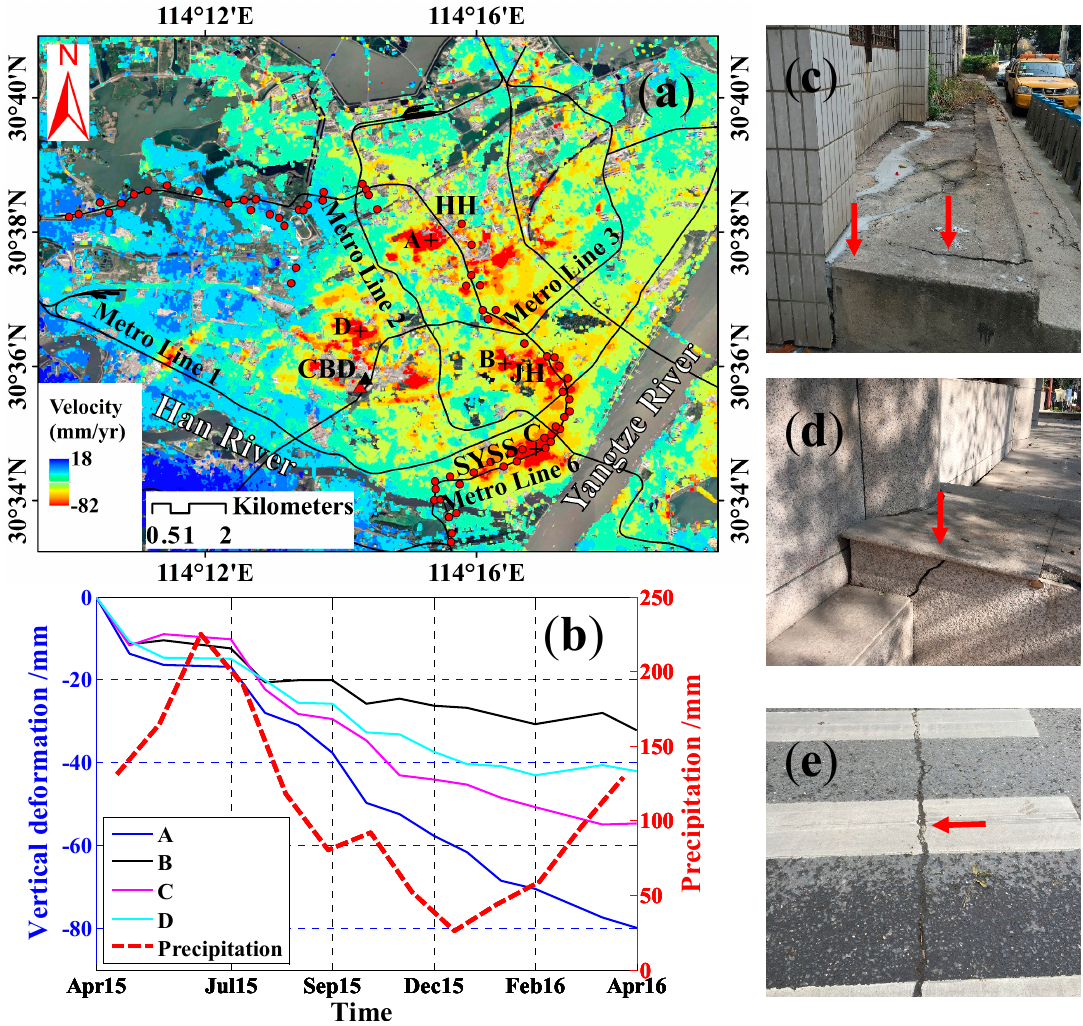
Figure 8. Surface vertical deformation rate map derived by SBAS InSAR superimposed on Google Earth image covering ( a ) Region S1. Black lines denote Wuhan Metro Lines, including metro lines in operation and under construction. Red circles represent leveling points distributed along Metro Line 6, which is under construction. Black and red triangles denote Wuhan Center and Wuhan World Trade Center, respectively. ( b ) Surface subsidence (in the vertical direction) time series with respect to PS points (marked by black crosses in Figure 8a) labeled as A, B, C, and D in Figure 8a versus average monthly precipitation of Wuhan area. ( c – e ) Structural damage caused by surface subsidence.